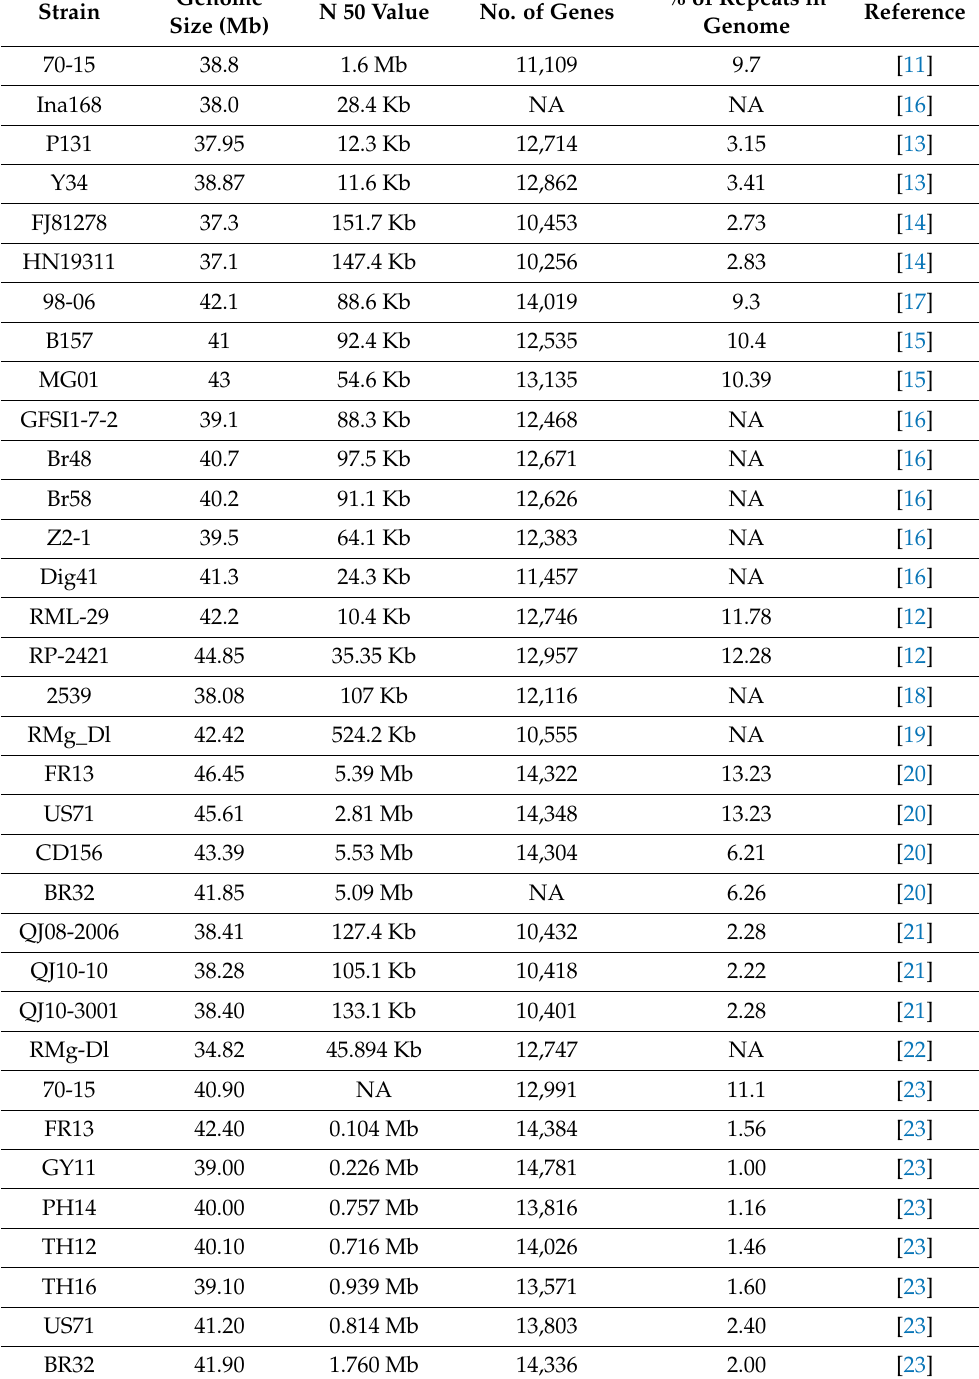
Table 1. List of Magnaporthe oryzae genome sequenced.